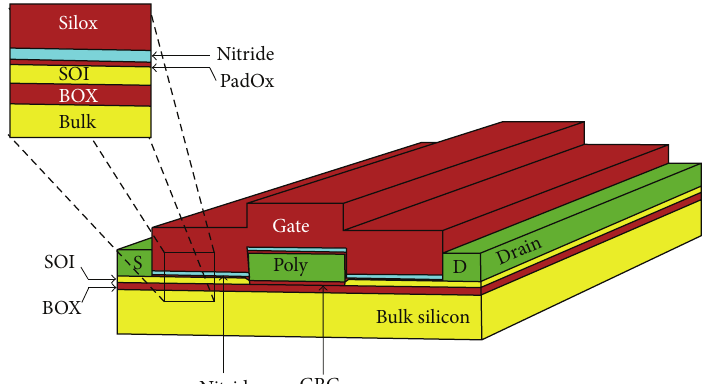
Figure 1: COMSOL 3D view of the GRC device is presented, showing a channel thickness of 2.2 nm. Scale 𝑋 : 𝑌 ratio is 100: 1.